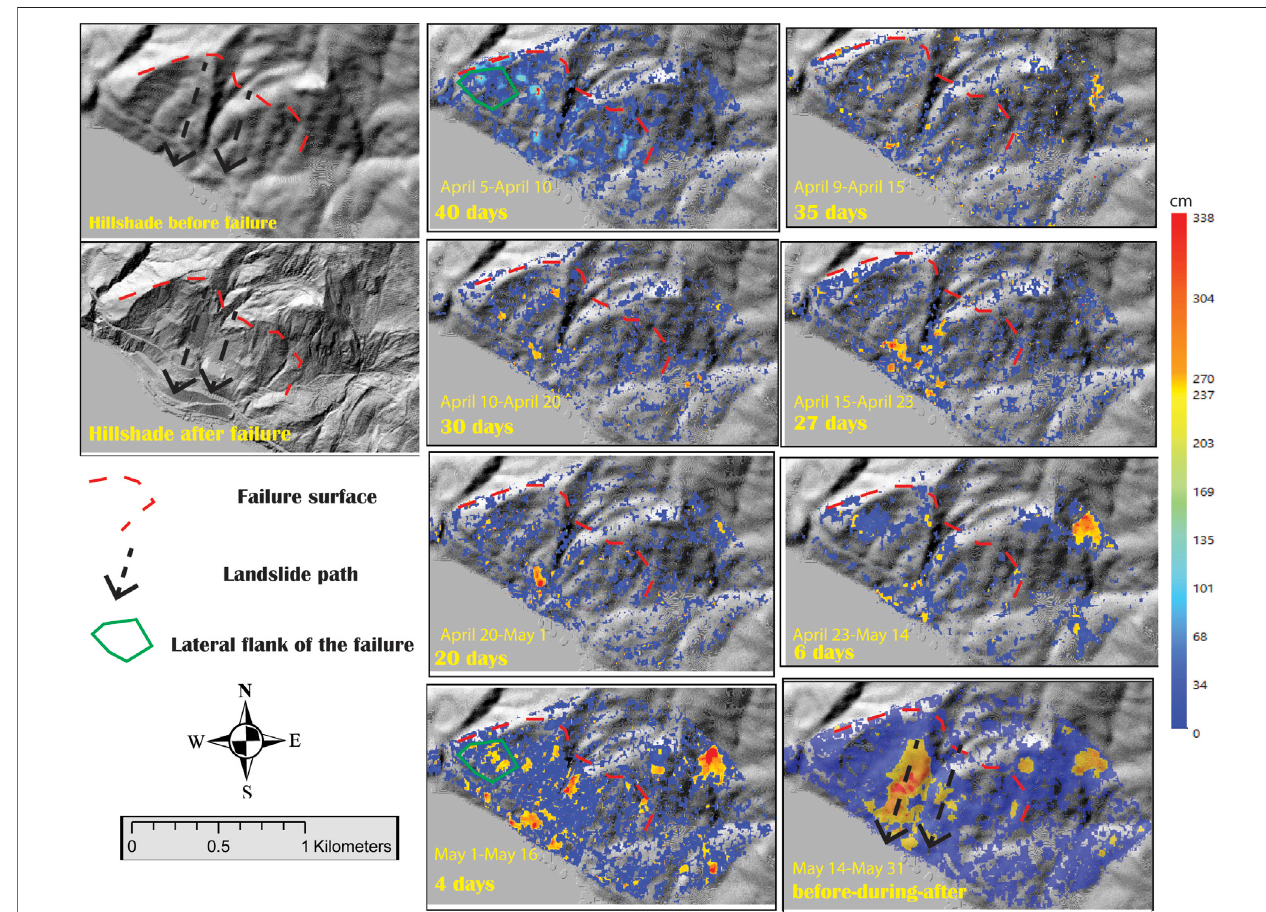
FIGURE 7 | Timestamp (number of days before the failure) horizontal displacement rate (cm per days) before the May 20, 2017, landslide. Note the location of the failure surface before and after the landslide.